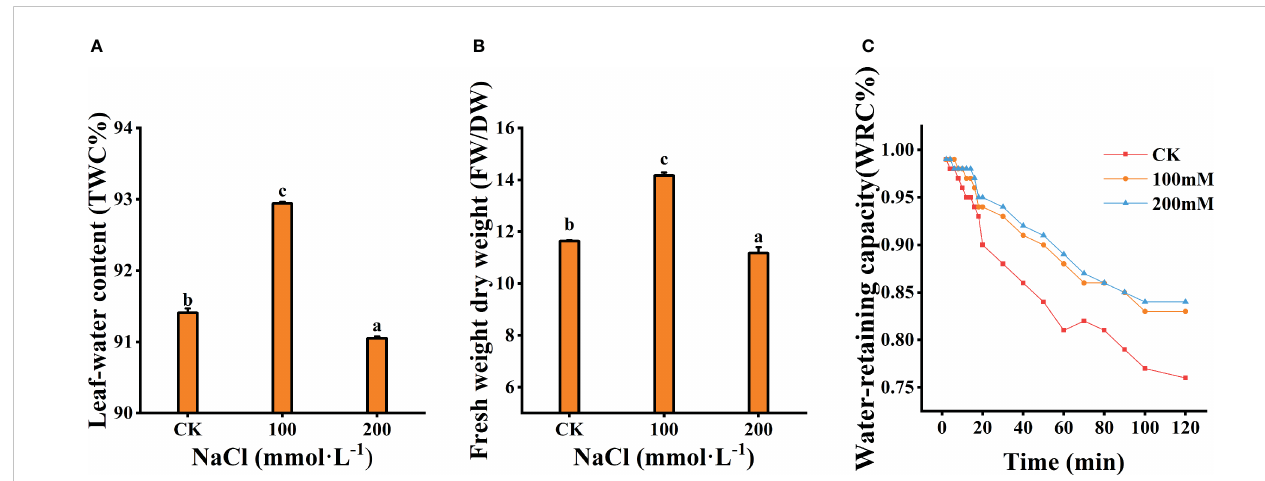
FIGURE 3 Effects of different salt concentrations on the water content and water-retaining capacity of the leaves. (A) Leaf-water content. (B) Fresh weight dry weight. (C) Water-retaining capacity. Data were analyzed by a Student ’ s t-test; a p <0.05 was considered as statistically signi fi cant.